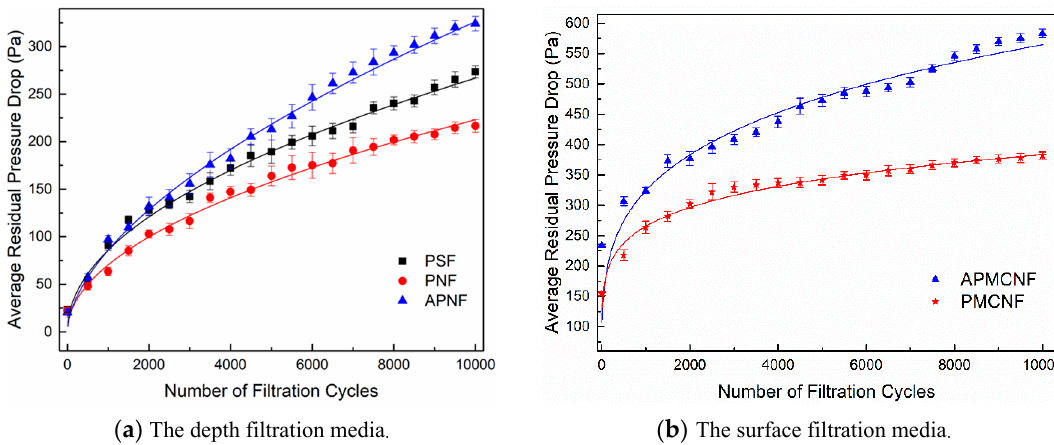
Figure 7. The changes in the average residual resistance drop of the five filter media during the fabric conditioning period.